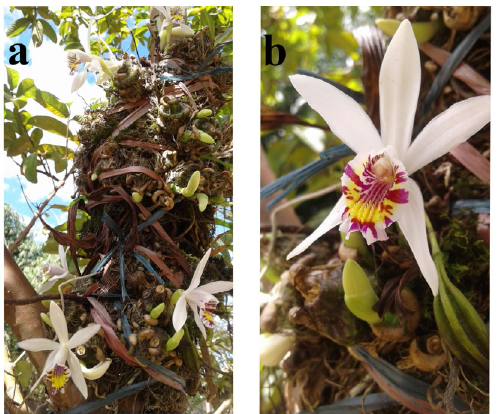
Fig. 1. Pleione maculata collected from Khliehriat, East Jaintia Hills (a) Habitat of P. maculata (b) P. maculata flowering during